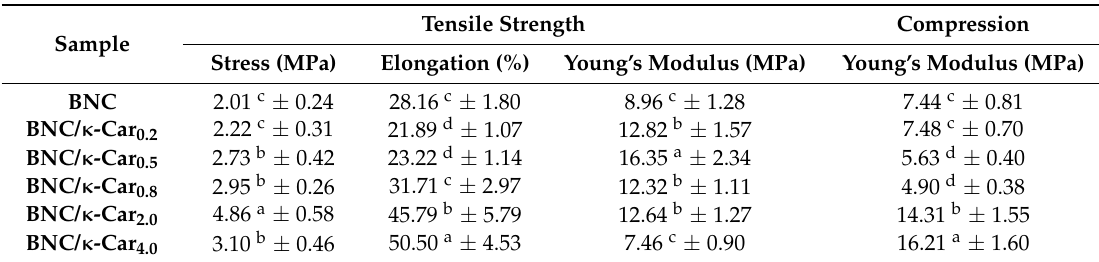
Table 3. Mechanical strength of BNC/ κ -Car composites (The data are presented as the means ± SD from at least twelve independent experiments; the means that are marked with different letters are significantly